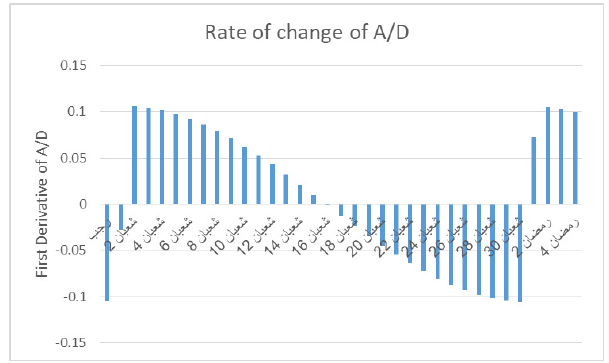
Figure 7. The model’s crescent visibility of Ramadan 1443 H.